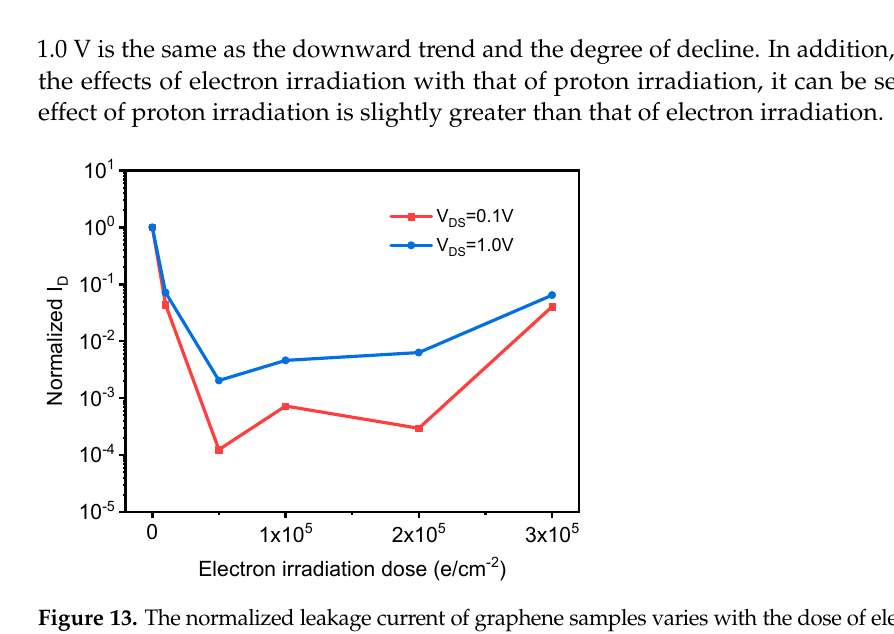
Figure 12. I–t curve of graphene samples before and after electron irradiation.